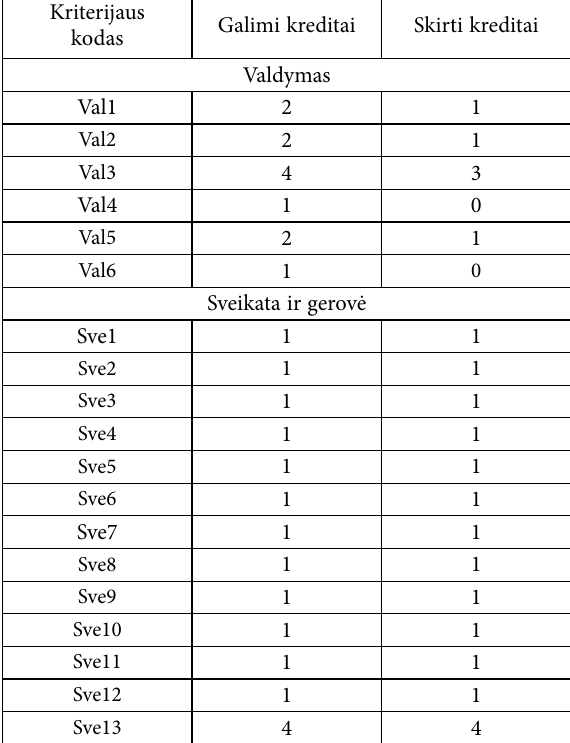
Table 3. Assessment of a multi-apartment building renovation project and the maximum values of criteria, in